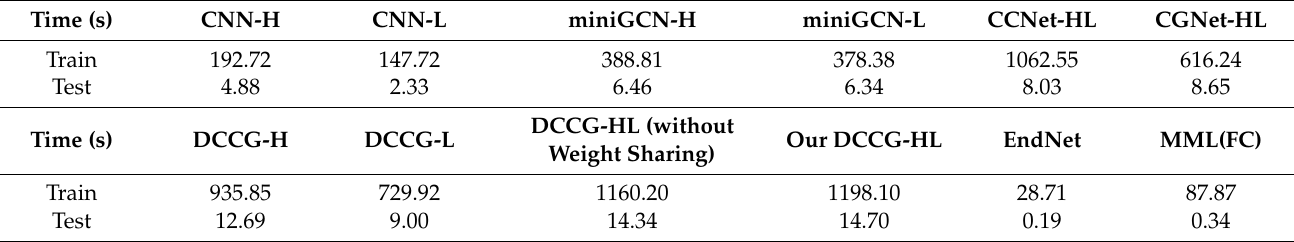
Table 8. Computation time (seconds) of different methods on the Trento